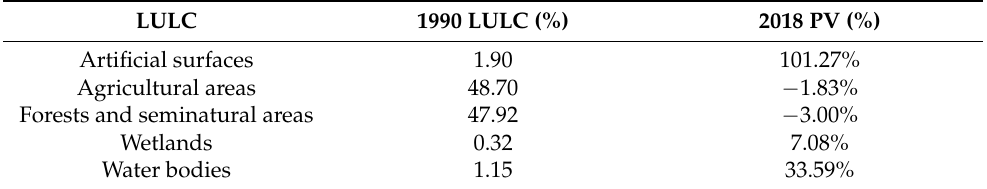
Table 1. Land Use Land Cover (LULC) percentage by 1990 and its percent variation (PV) by 2018.